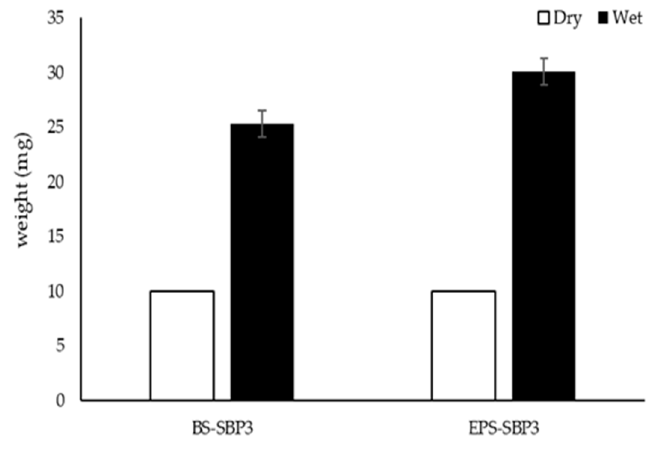
Figure 3. Weight of the BS-SBP3 and EPS-SBP3 before (dry) after (wet) 36 h of exposure to 100% air humidity.